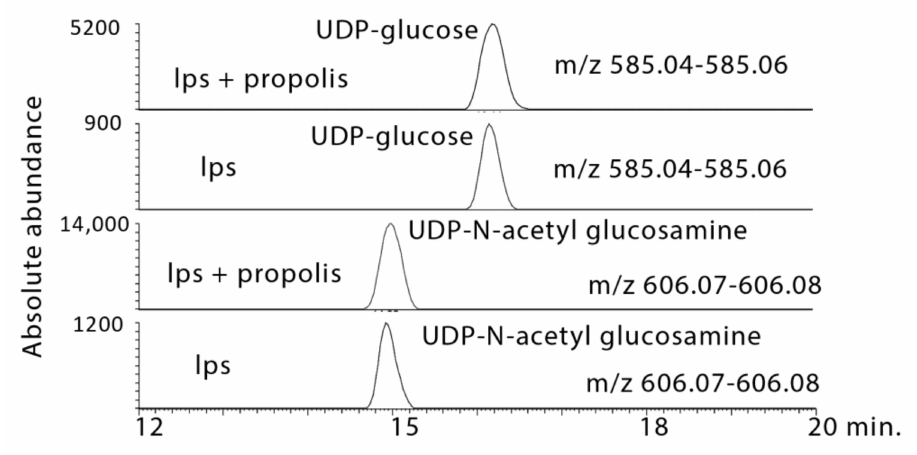
Figure 10. Extracted ion trace showing increases in UDP–glucose and UDP– N -acetyl glucosamine in LPS-stimulated macrophages treated with